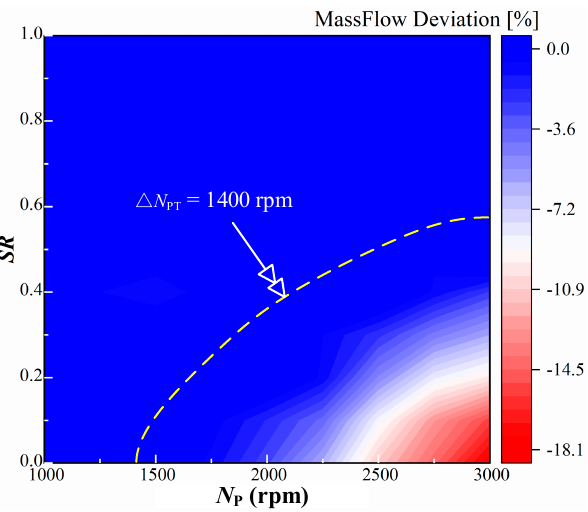
Figure 23. The influence of cavitation on mass flow in torque converter under various N P and SR .